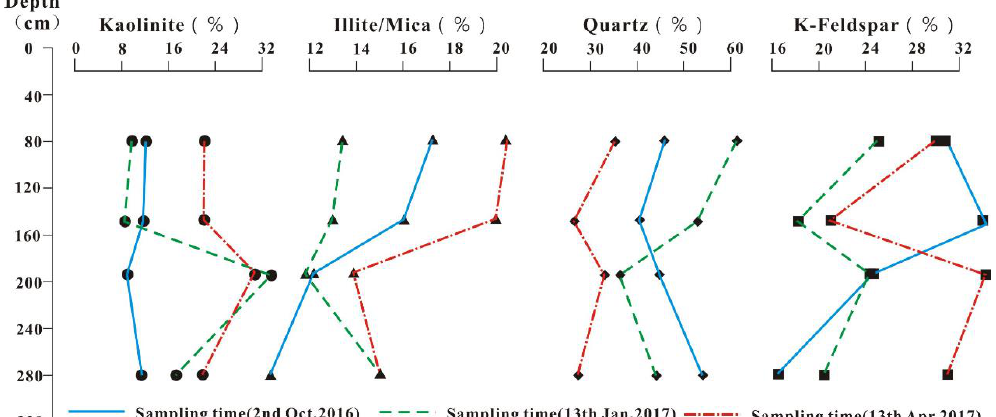
Figure 10. Clay mineral, quartz, and potassium feldspar content on the Longnan soil column at different stages of the leaching experiment.